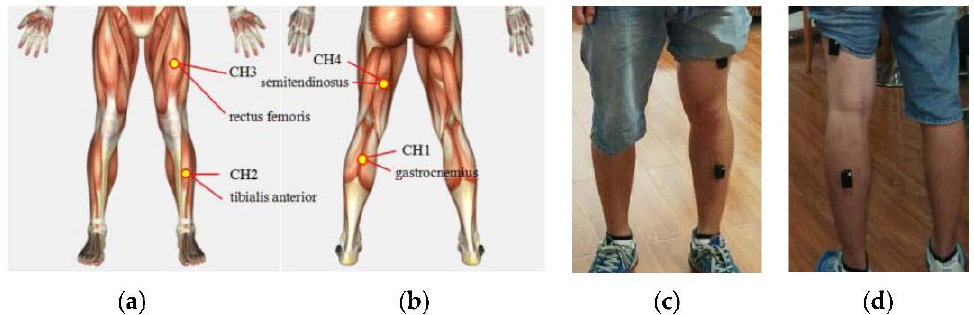
Figure 1. Muscles channels and sEMG sensors placement. ( a ) Forward muscle; ( b ) Backward muscle; ( c ) Forward sensors placement; ( d ) Backward sensors